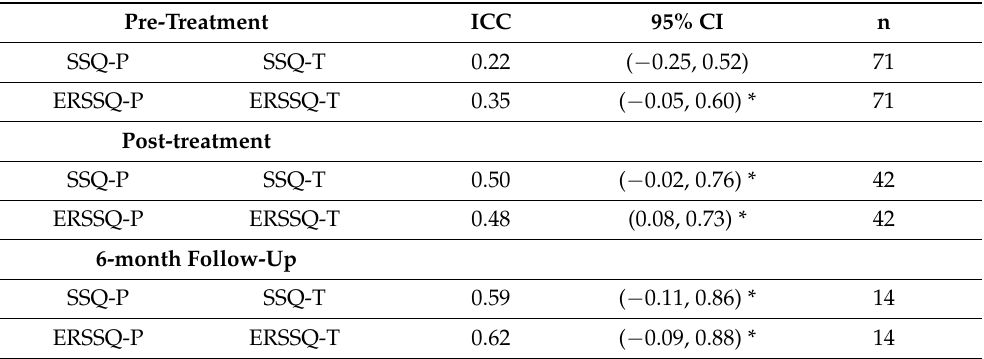
Table 4. Inter-rater agreement between parent- and teacher-report measures of children’s social emotional functioning at pre-treatment, post-treatment, and at 6-month